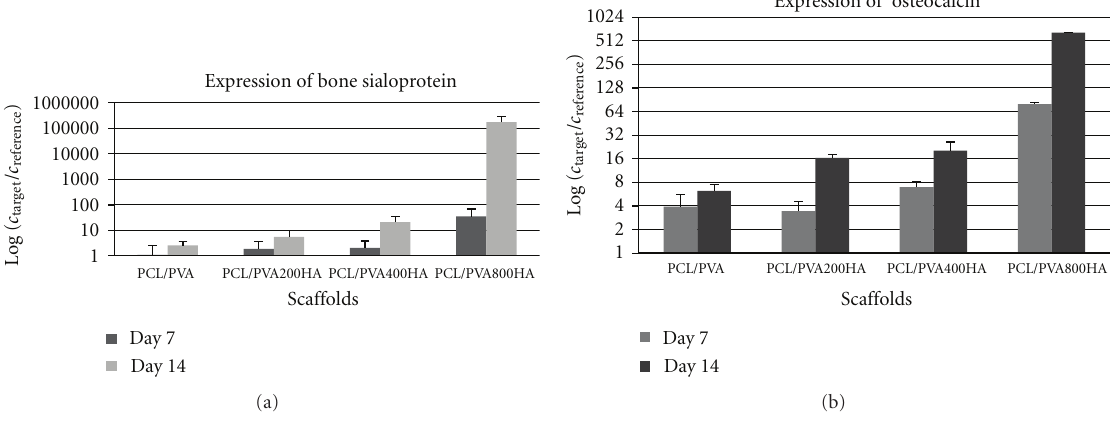
Figure 3: Expression of BS (a) and OC (b) genes. Osteogenic di ff erentiation of MSCs was detected by PCR analysis of expresion BS and OC genes on day 7 and 14 (mean ± standard